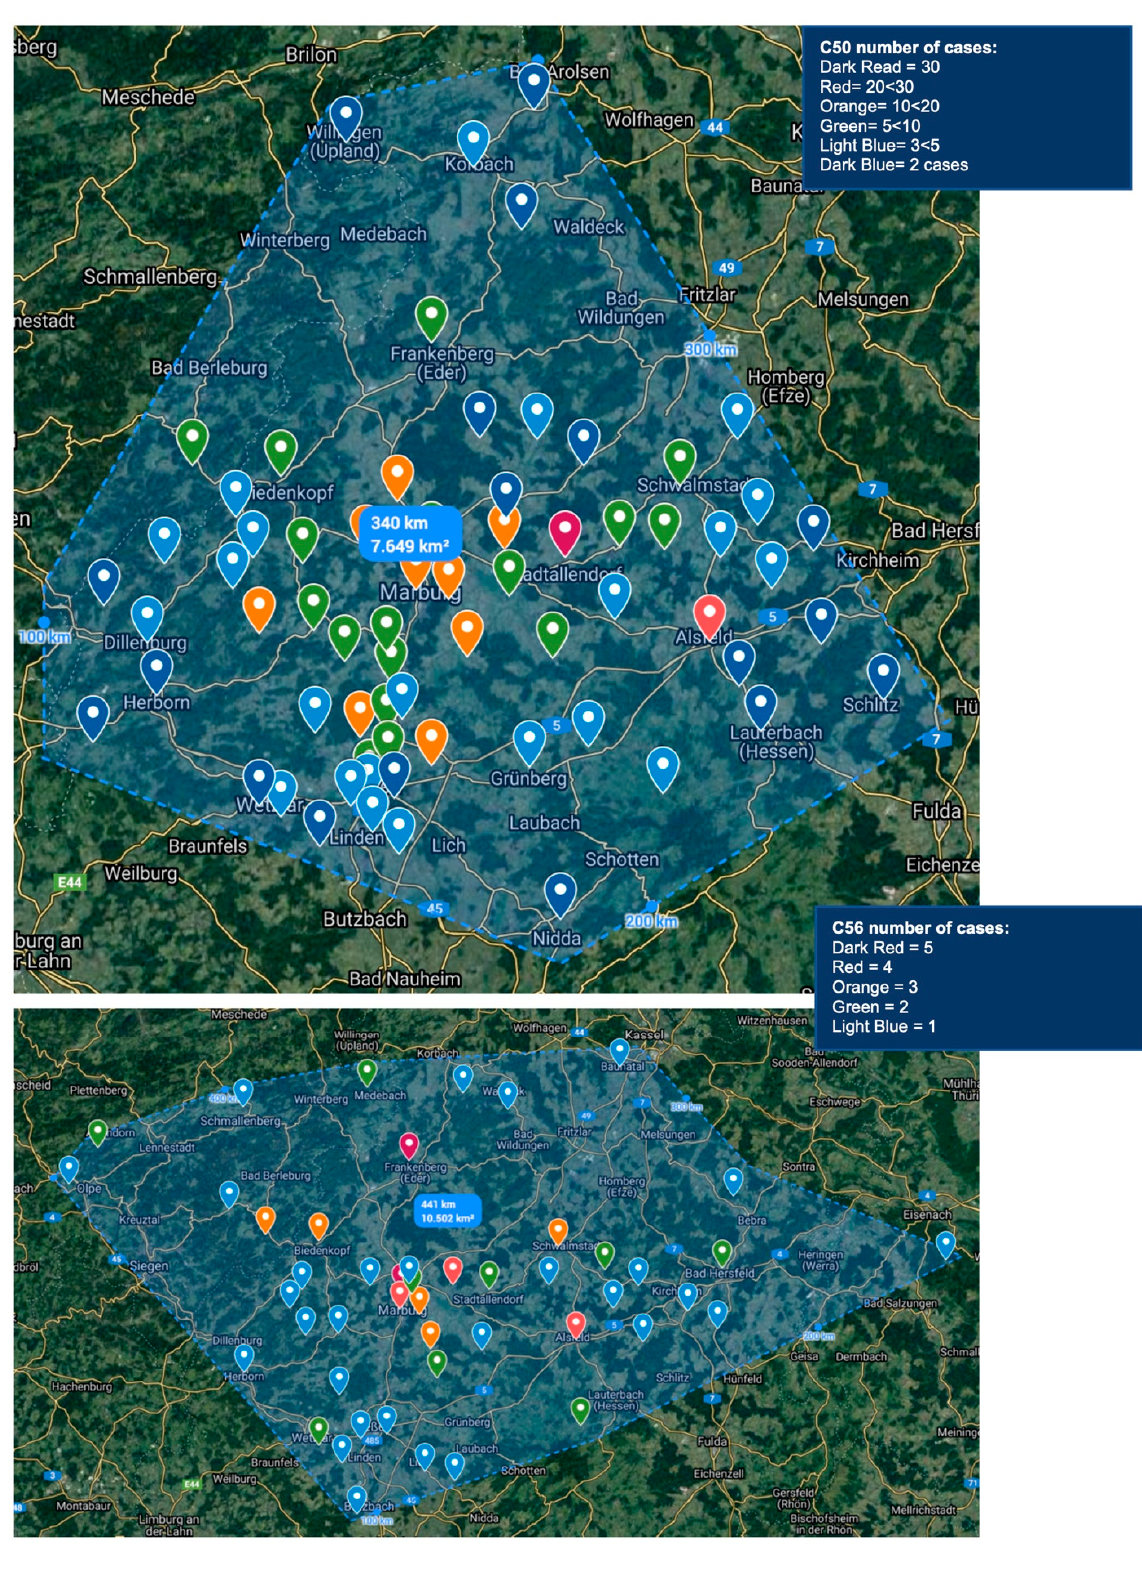
Figure 1. C50 and C56 geographical distribution by five-digit zip codes.